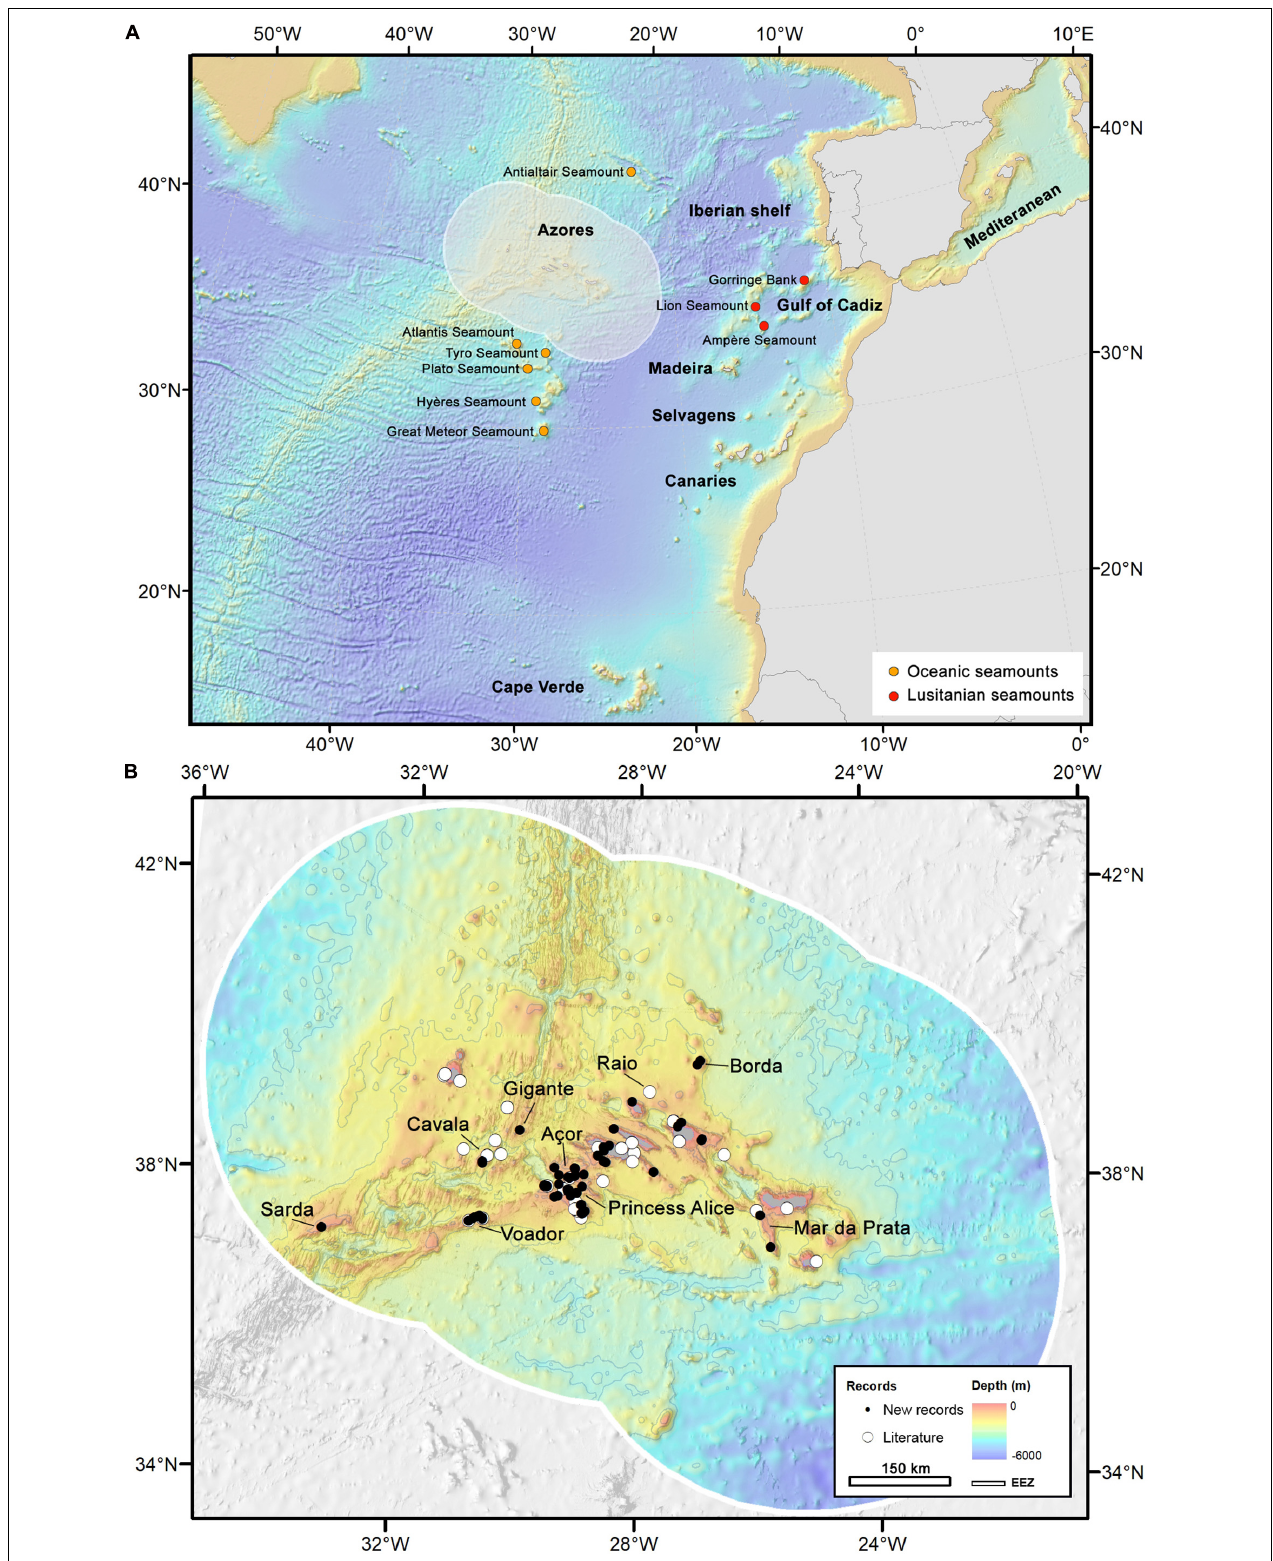
FIGURE 1 | Map of the study area. (A) Overall geographical setting, Northeast Atlantic and Mediterranean Sea, with archipelagos and main seamounts indicated. (B) The Azores EEZ with some geomorphological features indicated, and distribution of occurrence records: white circles represent records from the literature whereas black dots represent specimens analyzed in this